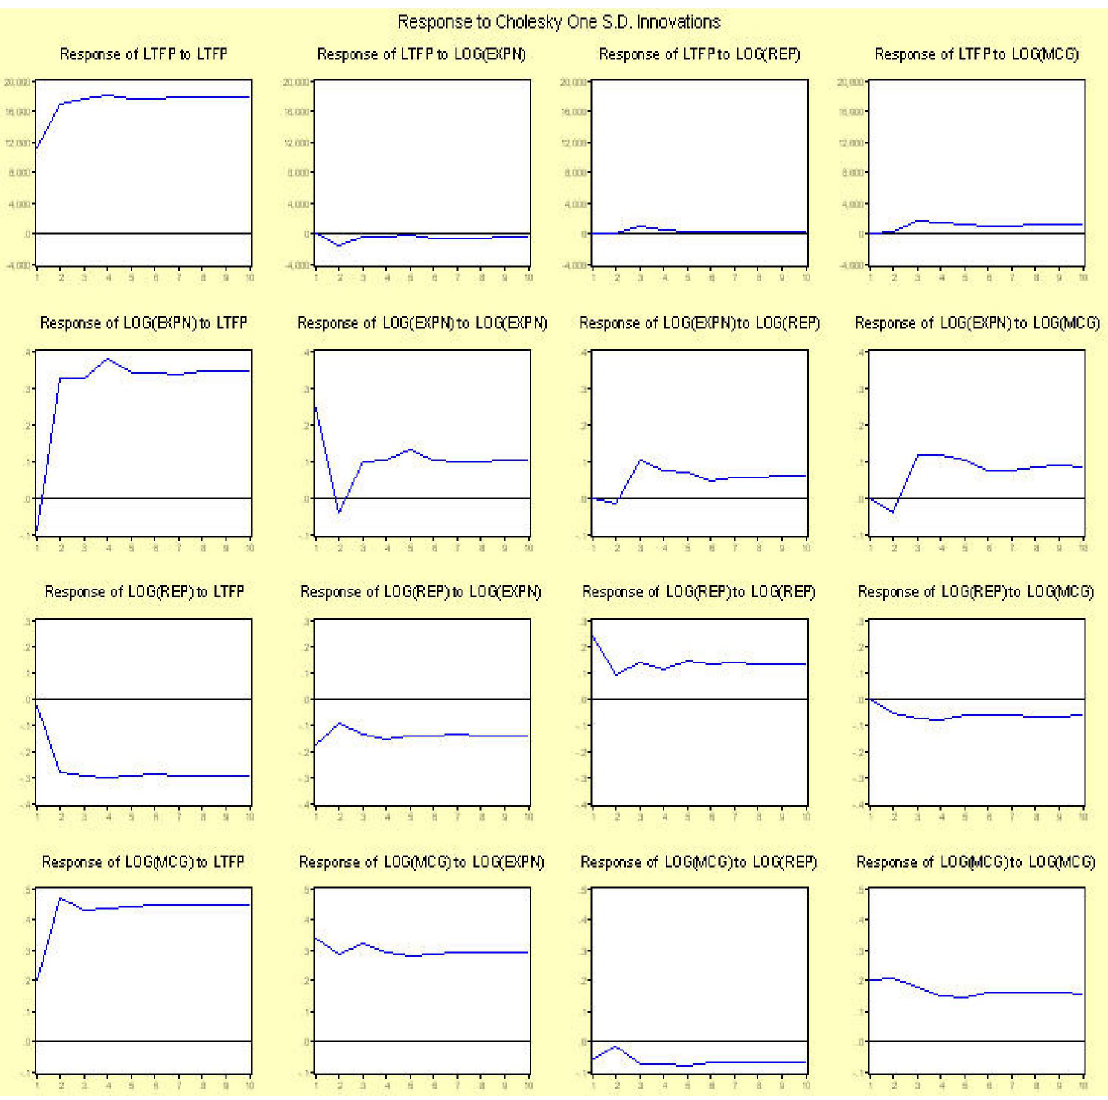
Fig. 1. The response of every variable to the shocks from other